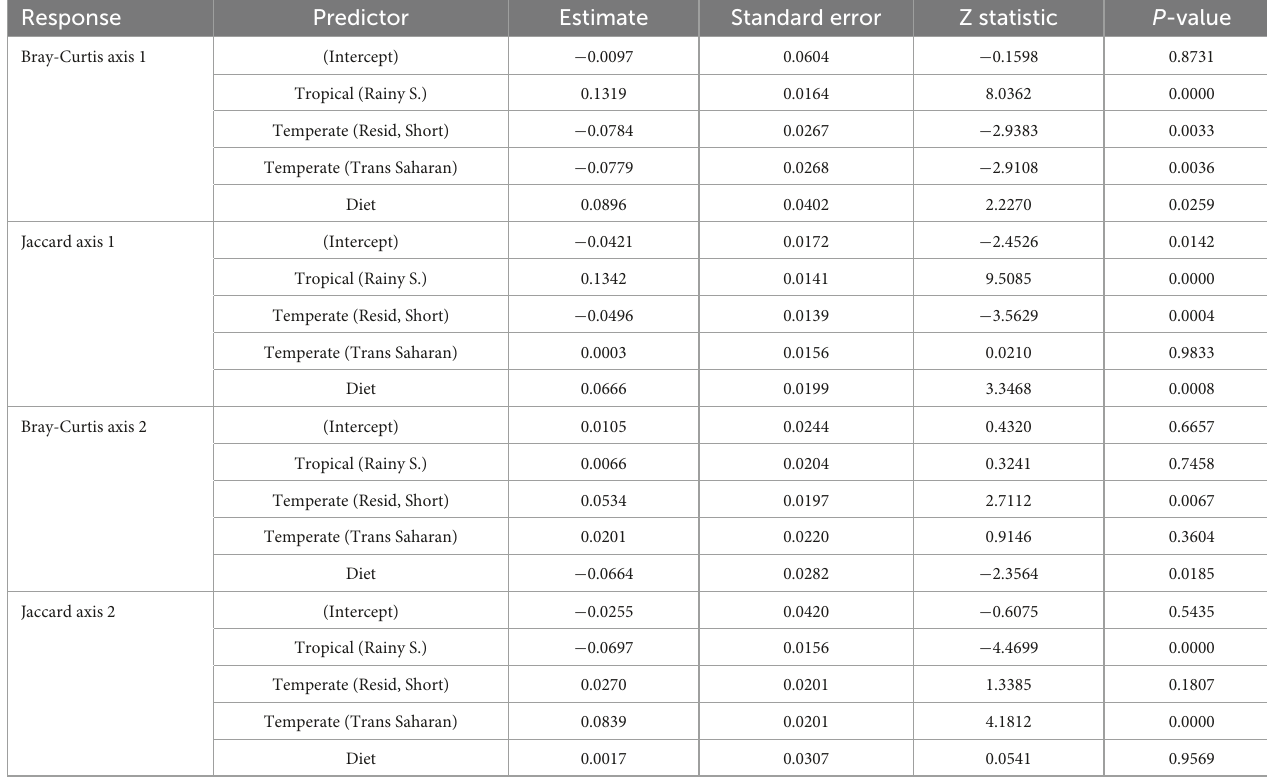
TABLE 2 Parameter estimates for mixed models testing the effect of climatic zones, season, migration, and diet on GM composition.